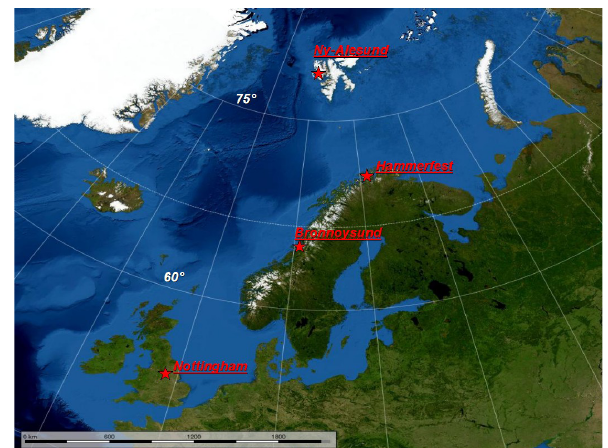
Fig. 1. Location of the